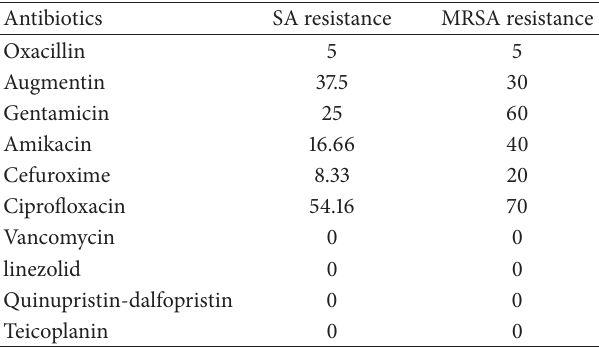
Table 2: Antibiotic resistance towards SA and MRSA.